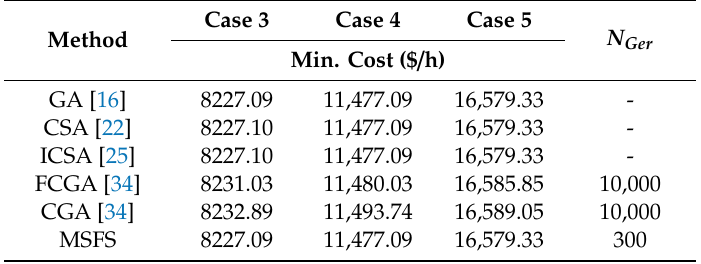
Table 7. Comparison of the implemented results for case 3, case 4, and case